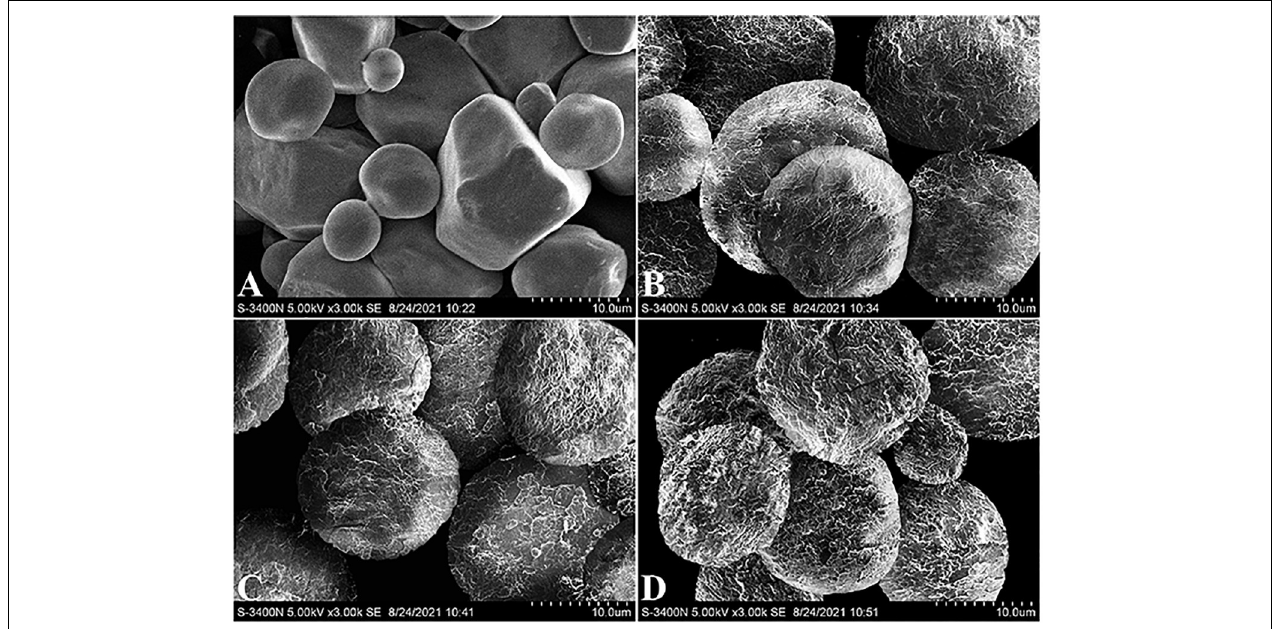
FIGURE 3 | Representative SEM images of native corn starch (A) and core-shell starch/zein microparticles crosslinked by TGase for 0 h (B) , 1 h (C) , and 2 h (D)